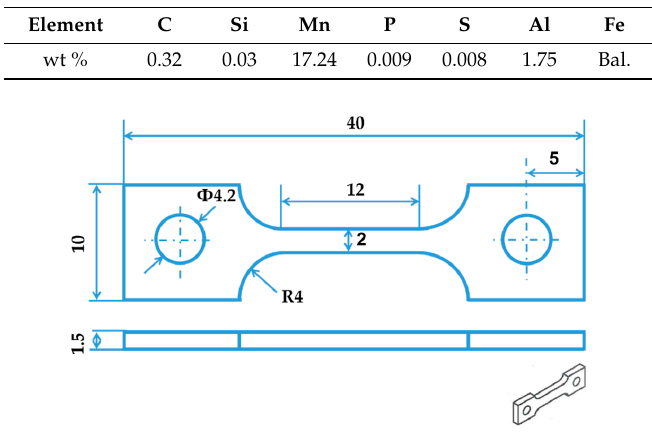
Figure 1. Geometry of the tensile specimen, in mm.